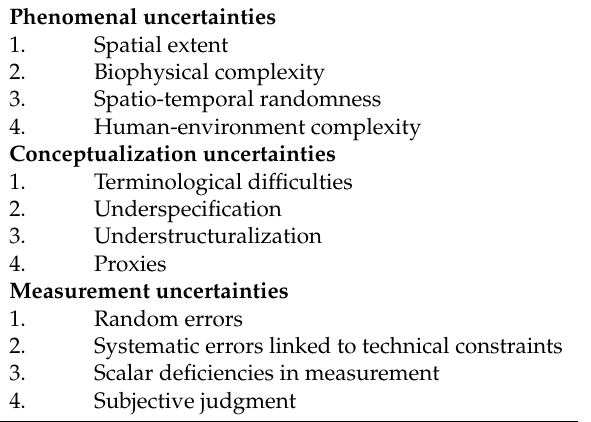
Table 4. Categories of sources of uncertainty in the Uncertainty Assessment